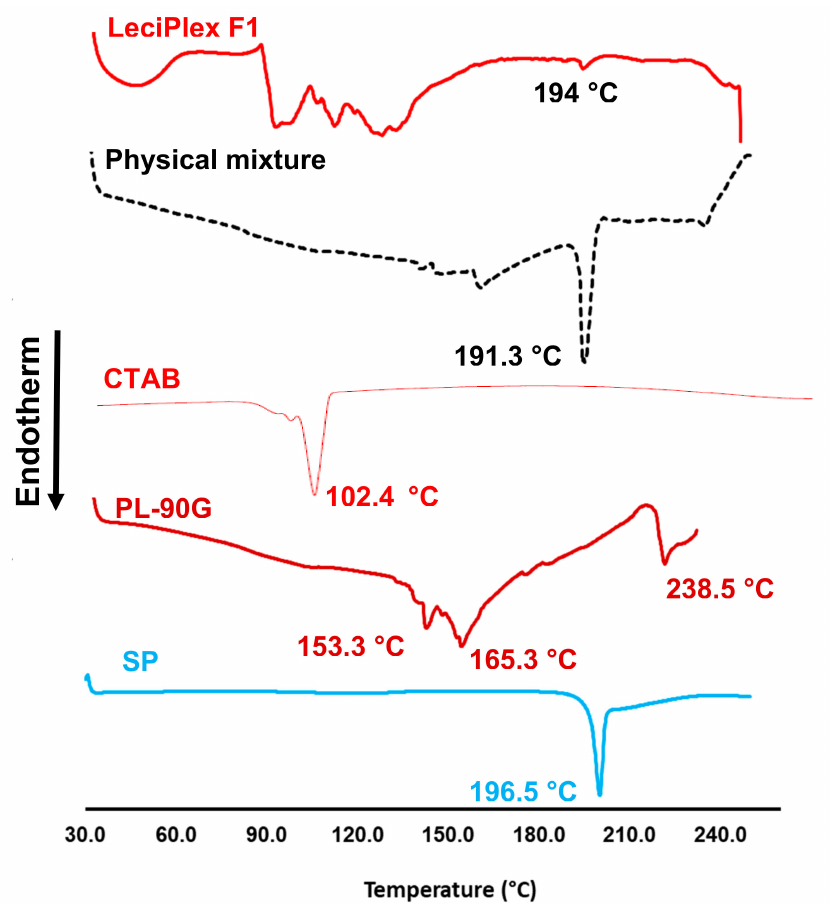
Figure 2. DSC thermograms of spironolactone (SP), Phospholipon ® 90G (PL-90G), CTAB, their physical mixture, and LeciPlex formulation